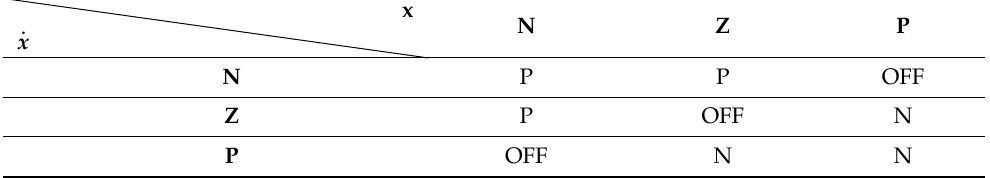
Table 3. Fuzzy rules used in the conventional FLC. P = positive, Z = 0, N =